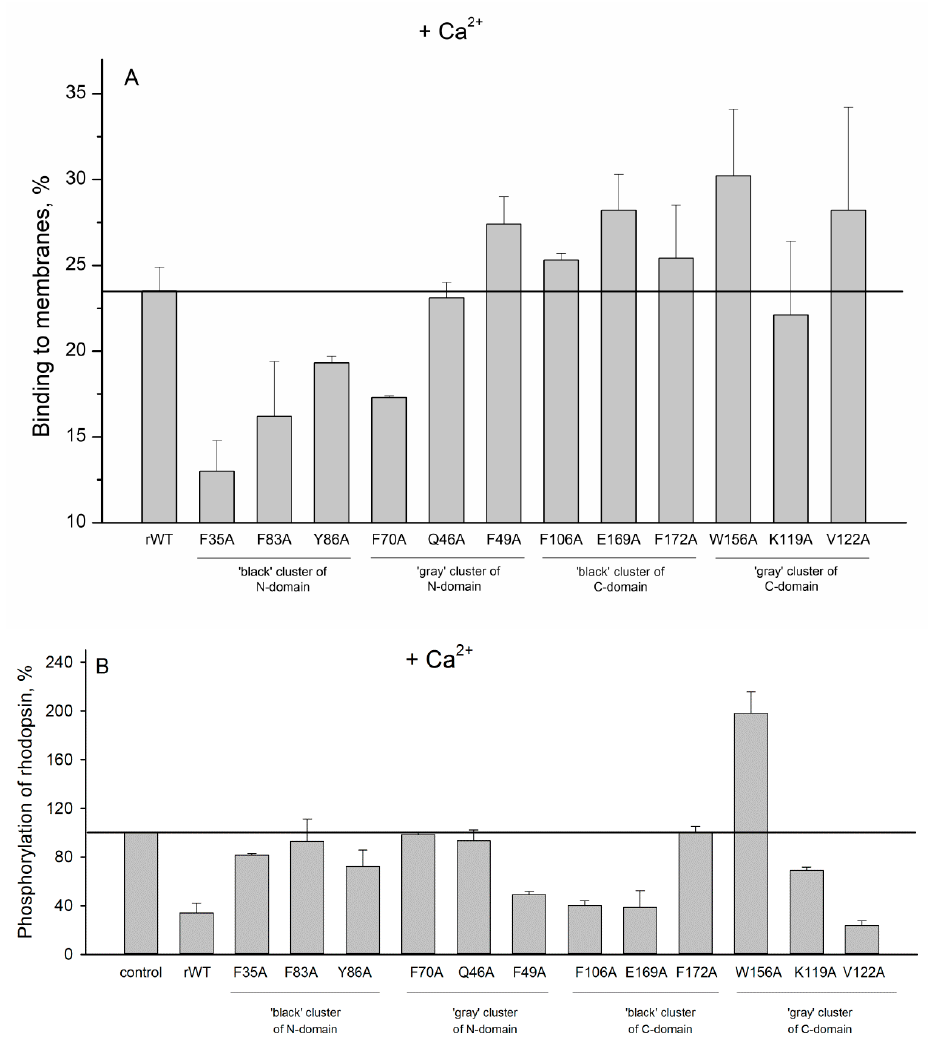
Figure 9. A : The binding of calcium-loaded rWT human recoverin and its cluster mutants to membranes. B : Effects of the alanine substitutions in the ‘black’ and ‘gray’ clusters in rWT human recoverin on phosphorylation of rhodopsin in the presence of calcium.